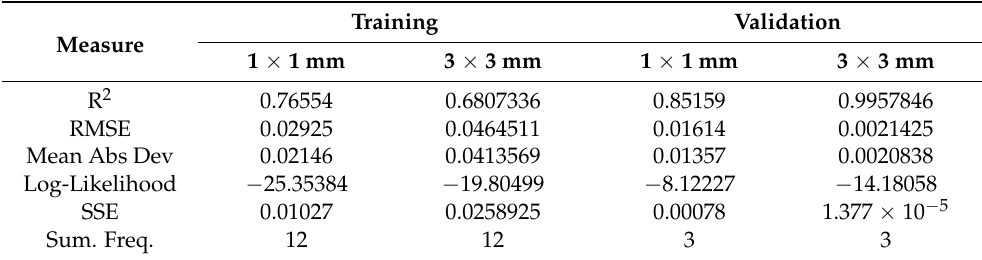
Table 3. Training and validation measures obtained for Y m dependent variable.